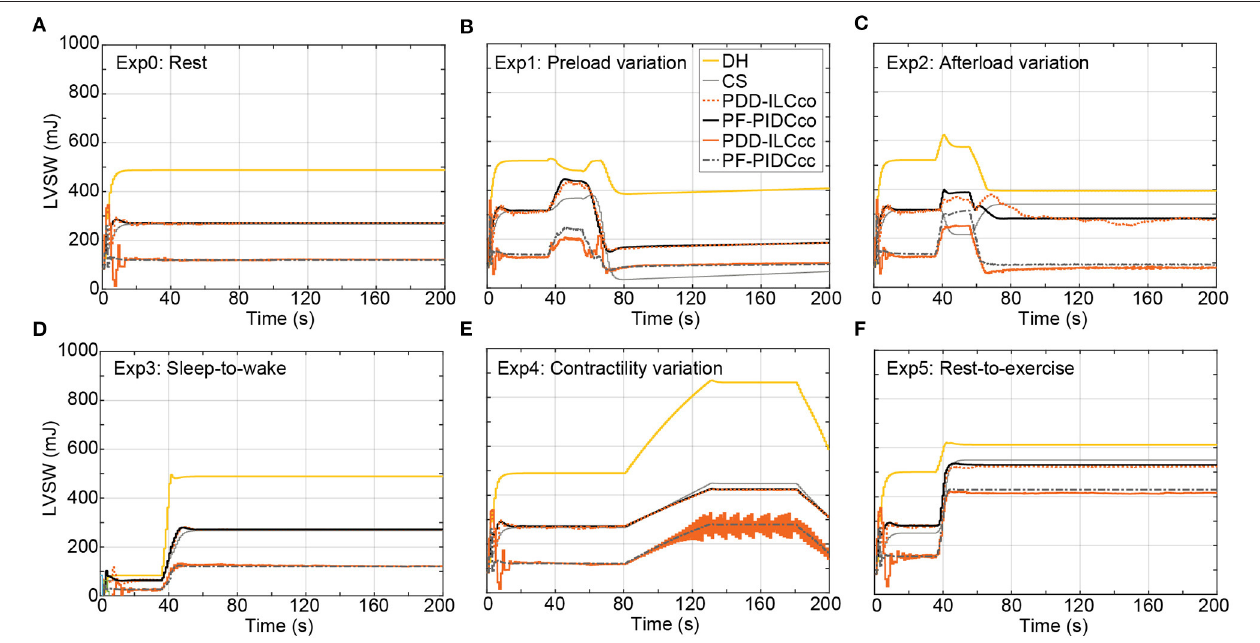
FIGURE 9 | Influence of the copulsation and counterpulsation modes on the left ventricular stroke work (LVSW) of the diseased heart (DH) during: (A) Rest-conditions (Exp0), (B) Preload variation (Exp1 (C) Afterload variation (Exp2) (D) Sleep-to-wake (Exp3) (E) Contractility variation (Exp4) (F) Rest-to-exercise (Exp5). DH, diseased heart; CS, constant speed control; PDD-ILCco, physiologic data-driven iterative learning controller copulsation; PF-PIDCco, pump flow proportional-integral-derivative controller copulsation; PDD-ILCcc, physiologic data-driven iterative learning controller counterpulsation; PF-PIDCcc, pump flow proportional-integral-derivative controller